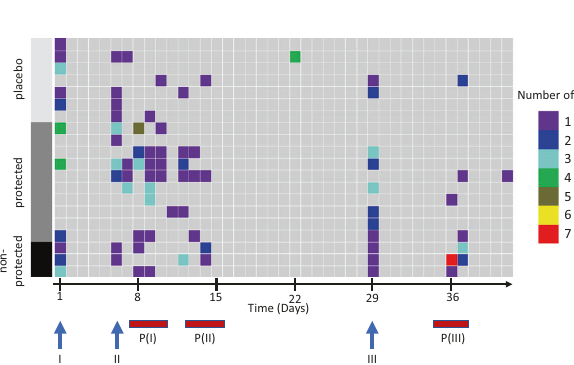
Fig. 5 Adverse events (AEs) over time during immunization period. AEs during the immunization period were recorded for each individual. The total number of mild and moderate AEs per individual (rows) and per day (columns) are plotted as a heatmap. The study population was divided into the subgroups of treatment allocation and CHMI outcome. Numbers of AEs are represented as given by the color scheme in the legend. Arrows highlight the time points of injection of the investigational product. Bars in burgundy indicate the period of transient parasitemia in vaccinees. AEs on Day 1 occurred after administration of investigational product. There were no AEs on days 2 – 5 after dose I or on days 30 – 35 after dose III. OD 1.0) to PfCSP 2 weeks after the third dose and just prior to CHMI were 17.6 and 18.1 times higher in uninfected (protected) (Fig. 7a). Quanti fi cation by a second assay of anti-PfCSP-speci fi c